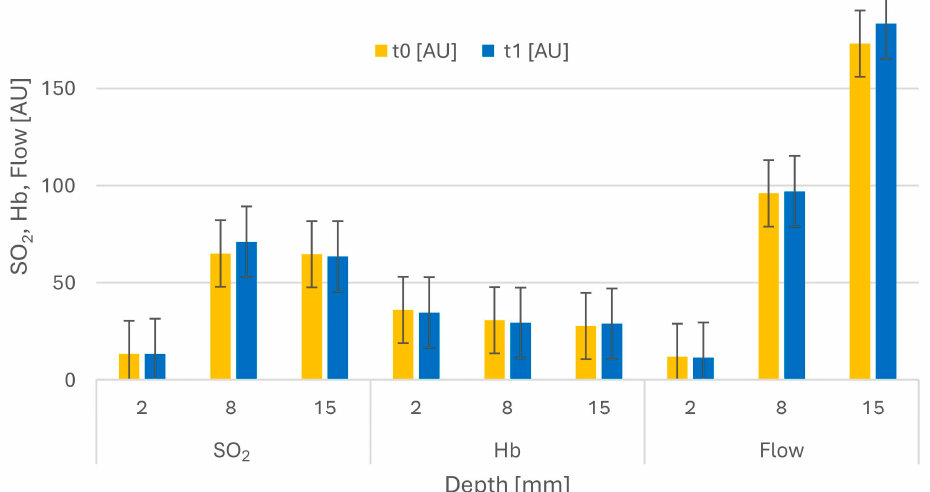
Figure 3. Mean values of t0 and t1 in the three depths in arbitrary units (AU). Bars indicate SD. Table 1. Overview of mean values in arbitrary units (AU) with SD of the time points t0 and t1 in the three different depths and p -values of the one-way ANOVA.